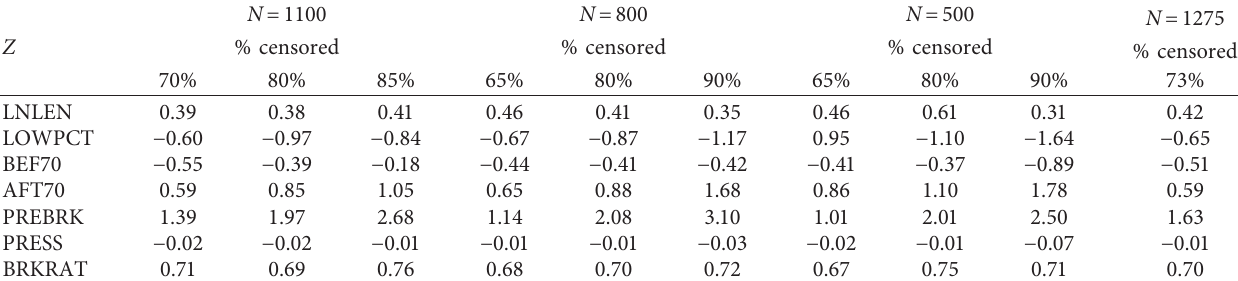
Table 1: Beta values for different cases.